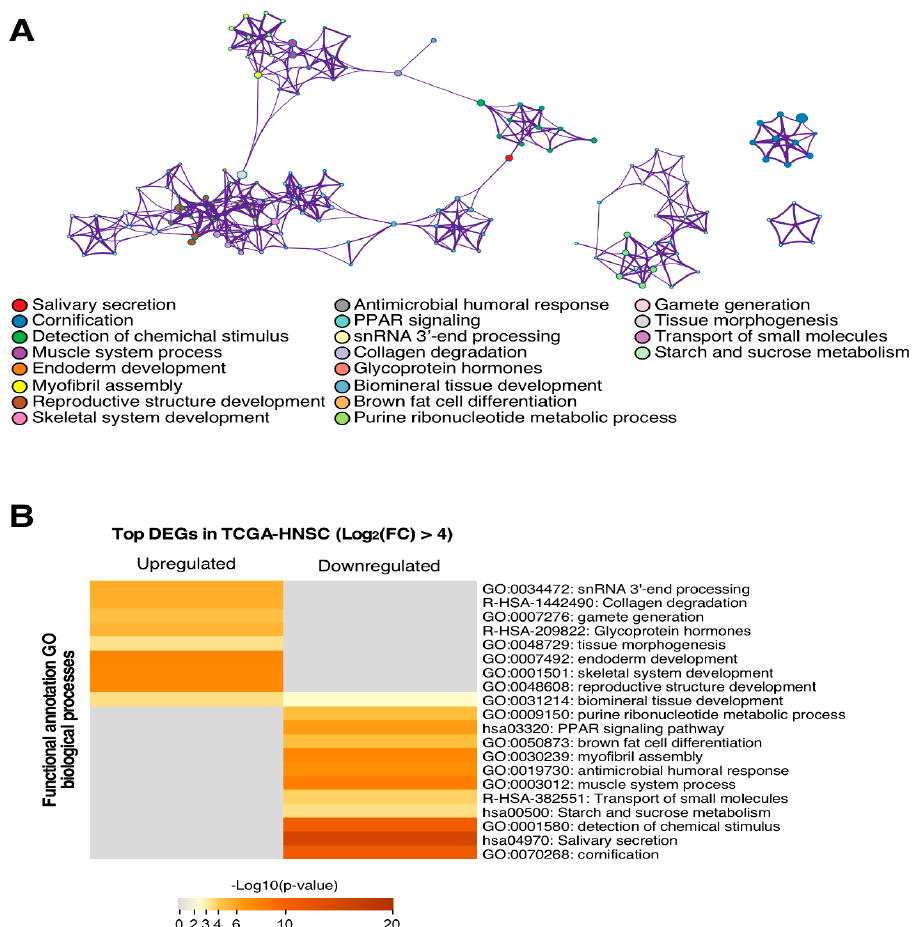
Figure 2. The functional annotation analysis shows the association of the genes with several biological processes. ( A ) Top differentially expressed genes both up- or down-regulated were annotated functionally in GO terms derived from the biological process. Each GO term is represented as a node and links show the gene sharing level between two nodes. Each colour represents one GO term as indicated in the legend. ( B ) GO terms are segregated depending on when they are more likely to be affected by up- or down-regulated genes. The heat map indicates the significant level of each term annotation depending on the number of genes contained from the input list.